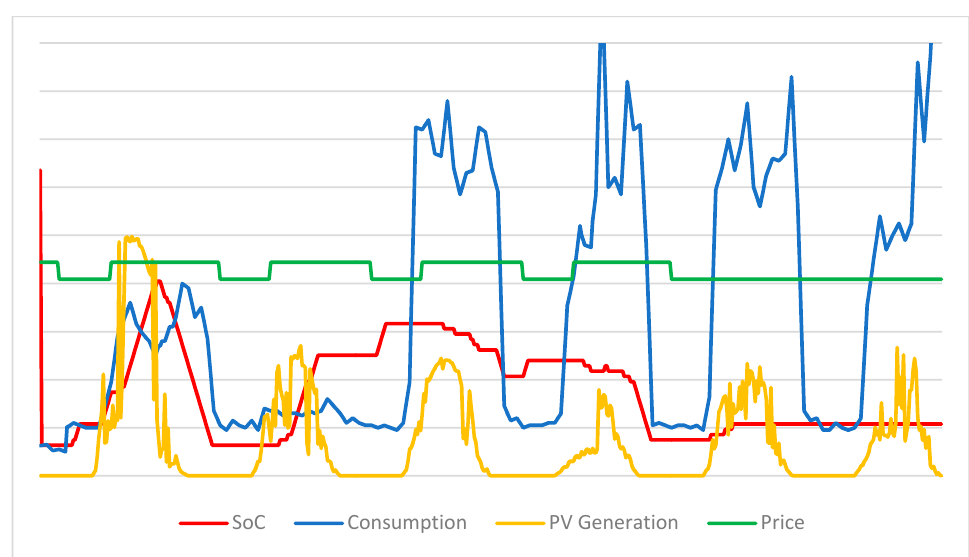
Figure 8. The operation of the BESS (price is dominant). The decision-making and optimisation al- gorithm follows the price signal, charges the battery when the price is low and discharges when the price is high.